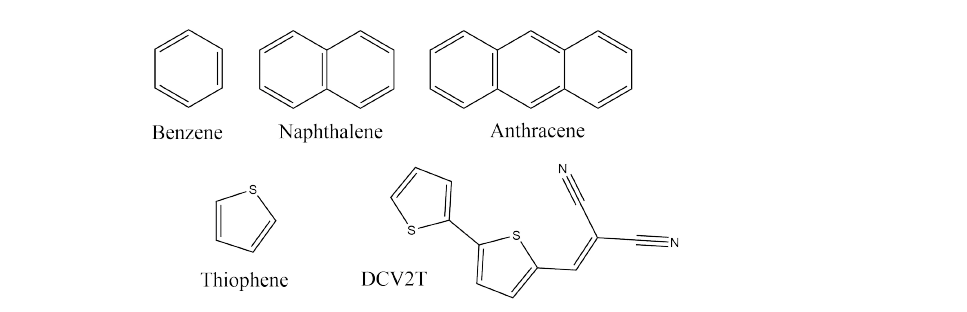
Figure 5. Candidate molecules for the creation of neuromorphic material based on porphine.